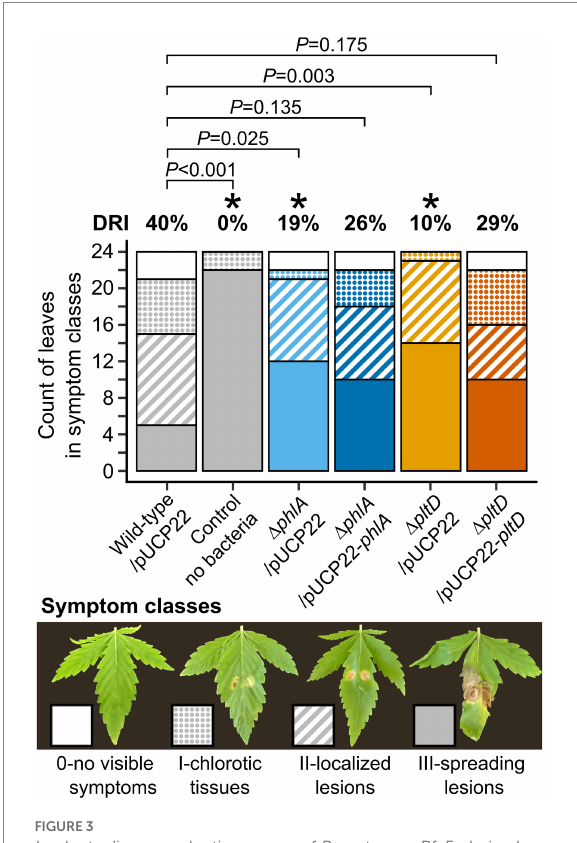
FIGURE 3 In planta disease reduction assays of P. protegens Pf-5-derived strains against cannabis gray mold disease. Leaves of 12-day-old cannabis plants were sprayed with normalized bacterial suspensions (10 5 CFU ml − 1 in water), or water for control plants. Leaves were infected 2 days later with two drops of B. cinerea conidia suspension (10 3 conidia ml − 1 ). Symptoms were observed 8 days after infection when control plants exhibited strong disease symptoms, and disease severity was scored using the four-class scale presented by pictures. The disease reduction index (DRI) was calculated for each treatment relative to the control plants without bacteria, as detailed in Methods. Stacked barplots represent the count of leaves in each symptom class from two independent experiments containing 12 plants each ( n = 24). Exact p values are indicated for comparisons with plants treated with wild-type/pUCP22 according to Fisher’s LSD post-hoc analysis with Benjamini-Hochberg correction, * represents p <